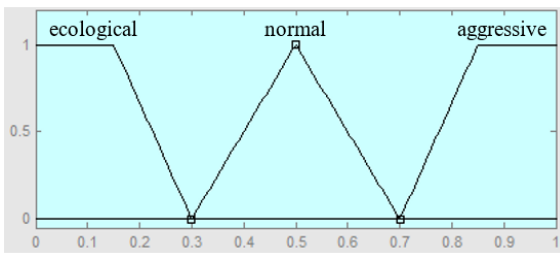
Figure 8. Membership functions of the driving-style fuzzy variable.